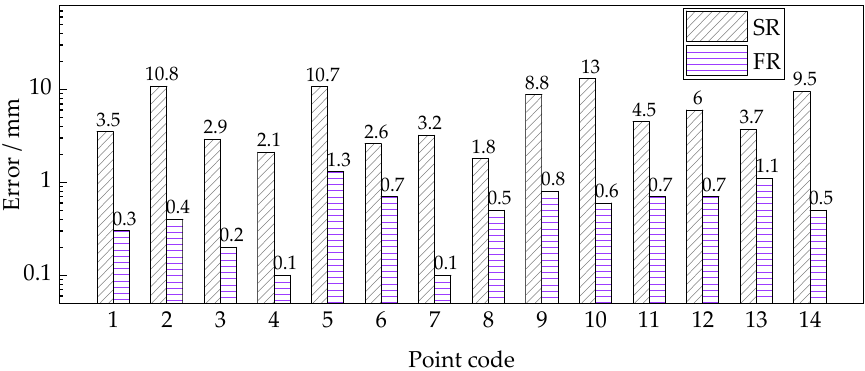
Figure 11. Errors of points deformation measurement by using the reconstructed 3D beam models.